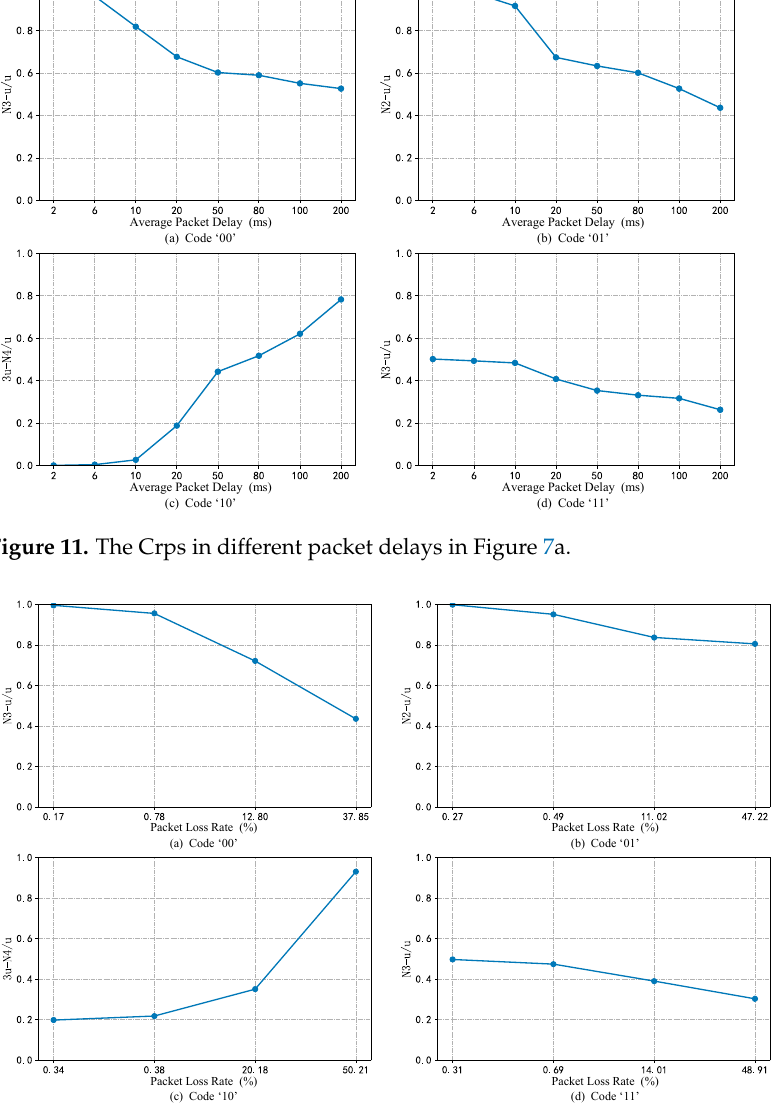
Figure 11. The Crps in different packet delays in Figure 7a.